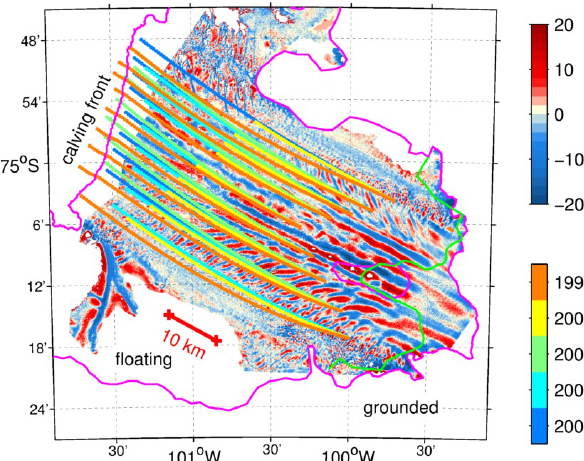
Fig. B1. Small-scale surface elevation anomaly (colour) is overlaid by selected coloured streamlines of the ice surface velocity for 6 of Figure B1 Small scale surface elevation anomaly (colour) is overlaid by selected coloured the available observed years. All streamlines start at the same point streamlines of the ice surface velocity for 6 of the available observed years. All streamlines start at the same point each year but end wherever ice velocity observation is lacking. The choice of each year but end wherever ice velocity observation is lacking. The starting point is optimised to consistently show as many years and cover as much ground as choice of starting point is optimised to consistently show as many possible. years and cover as much ground as